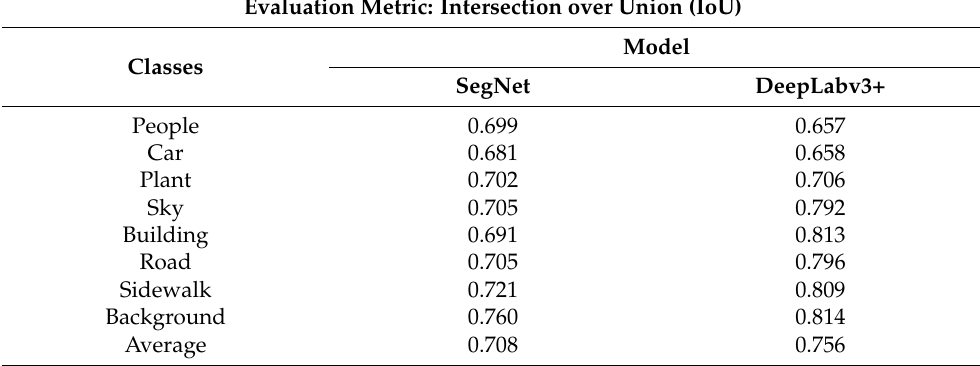
Table 1. Segmentation result for the cityscapes